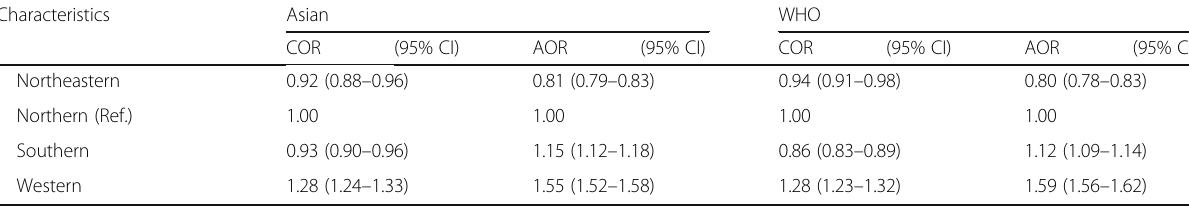
Table 3 Determinants of underweight among women of reproductive age in India 1,2 (Continued)